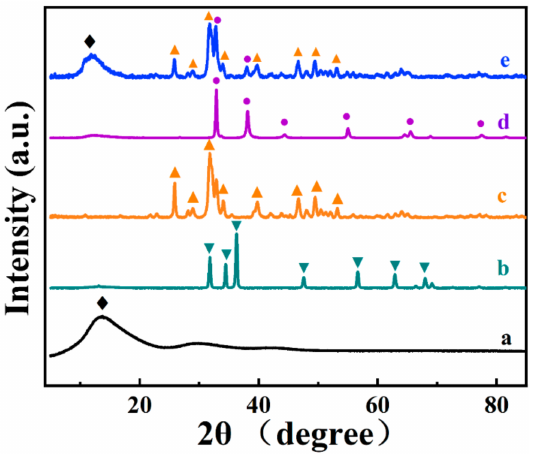
Figure 4. X-ray diffraction patterns of ( a ) as-received PMMA, and composites ( b ) PMMA-ZnO, ( c ) PMMA-HAP, ( d ) PMMA-Ag 2 O and ( e ) PMMA-HAP-Ag 2 O, (cid:72) —JCPDS file 04-020-9583, (cid:78) —JCPDS file 04-008-4759, • —JCPDS file 00-041-1104, (cid:7) —PMMA.